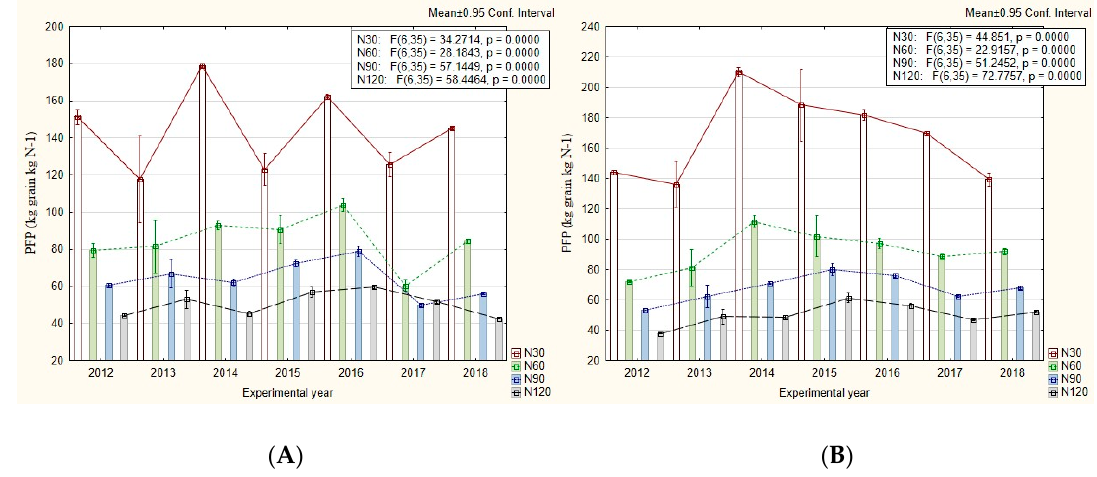
Figure 4. PFP, as affected by planting pattern (( A )—WM; ( B )—WS), N fertilization and experimental Figure4. PFP,asa ff ectedbyplantingpattern(( A )—WM;( B year.